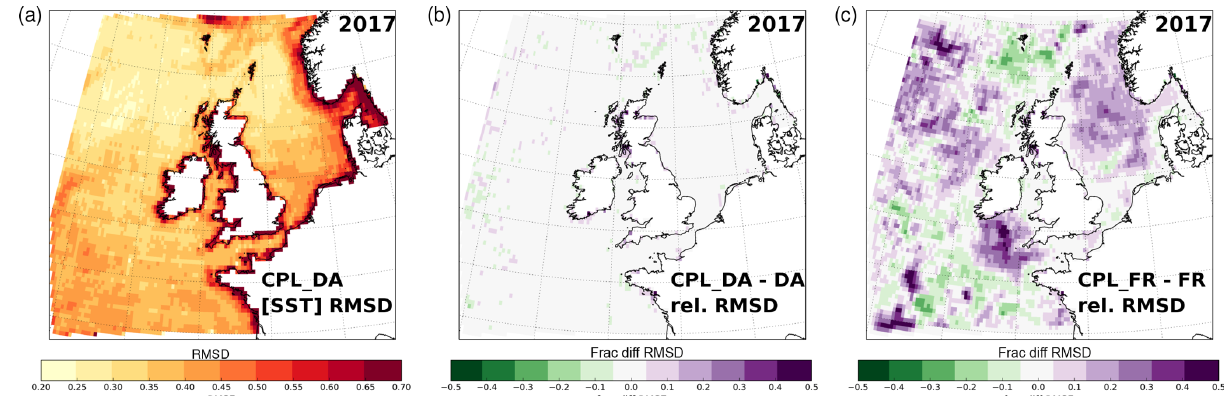
Figure 5. (a) Distribution of RMSD for CPL_DA during 2017 comparing simulated SST with all in situ and satellite observations prior to assimilation. (b) Fractional change in RMSD ((CPL_DA – DA)/DA) due to wave coupling in assimilative runs. Panel (c) as (b) comparing RMSD ((CPL – FR)/FR) due to wave coupling for non-assimilating runs. Positive differences (purple shading) indicate a relative degradation of performance with wave coupling.